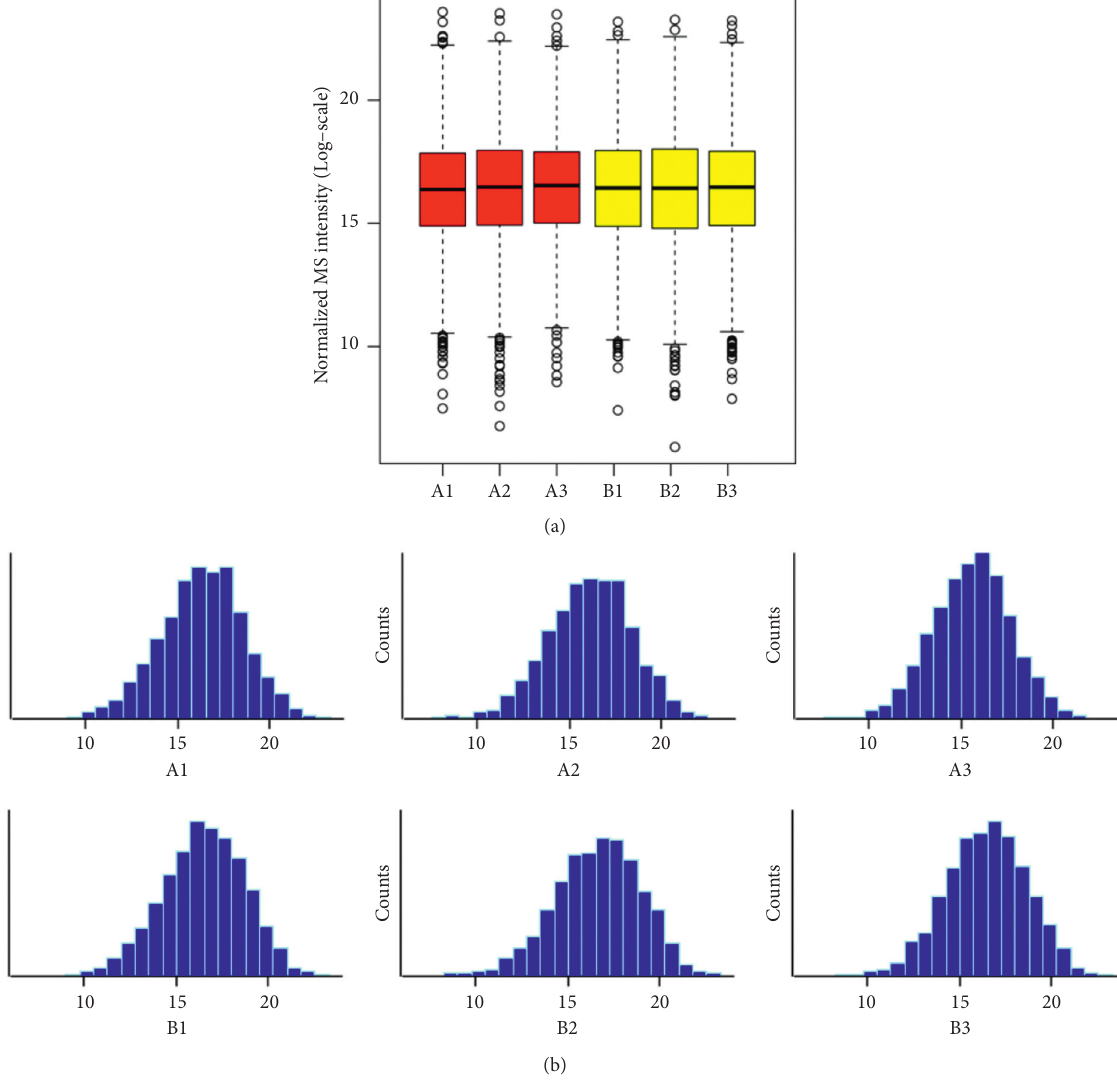
Figure 1: (a) Histogram of log2 protein intensity for each sample. (b) Box plots of log2 protein (or reporter ion) intensity average for each